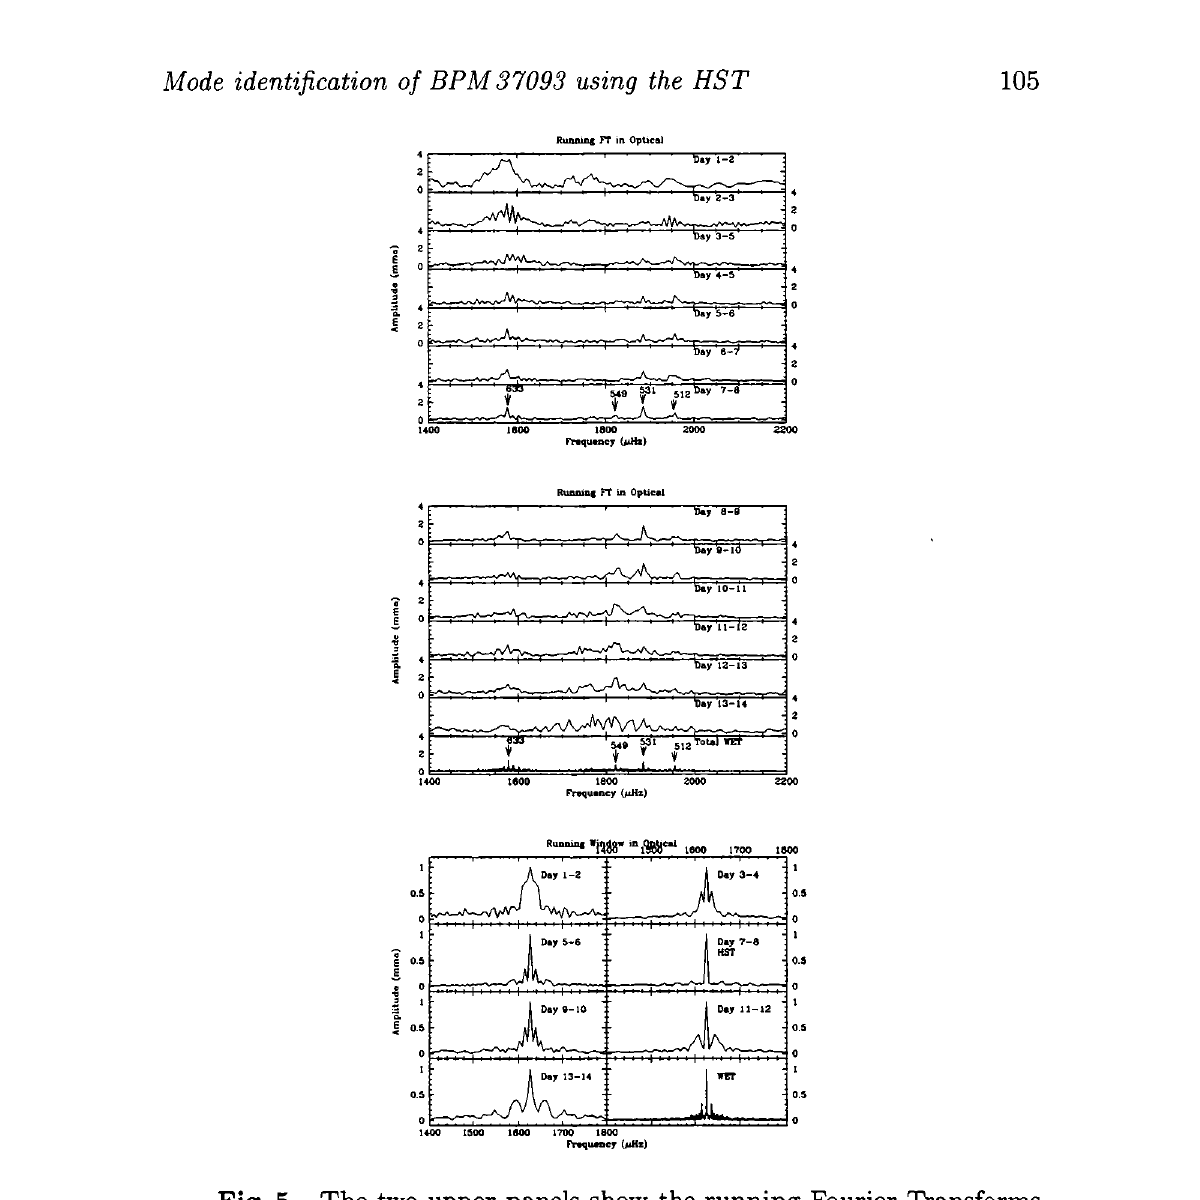
Fig. 5. The two upper panels show the running Fourier Transforms of the 2-day optical lightcurve. One can see how the power spectrum changes during the WET run. Each panel is labeled by the days of the light curve used to produce the Fourier Transforms. For instance, Day 1 -2 means the data from the 1st and 2nd day of the WET run. The panel shows Day 7 -8 which overlaps with the HST observation, and we labeled the modes by their periods. The Fourier Transform of the total WET data is shown at the bottom of the second panel. The third panel shows the corresponding spectral